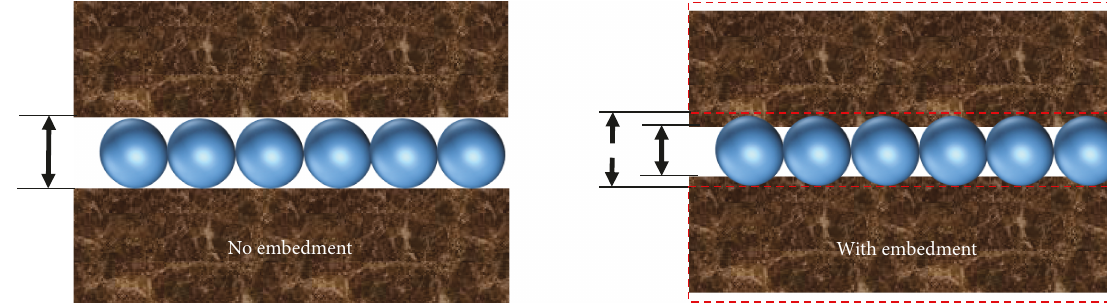
Figure 1: Geometry before and after proppant embedment. Table 1: Basic parameters for fl ow